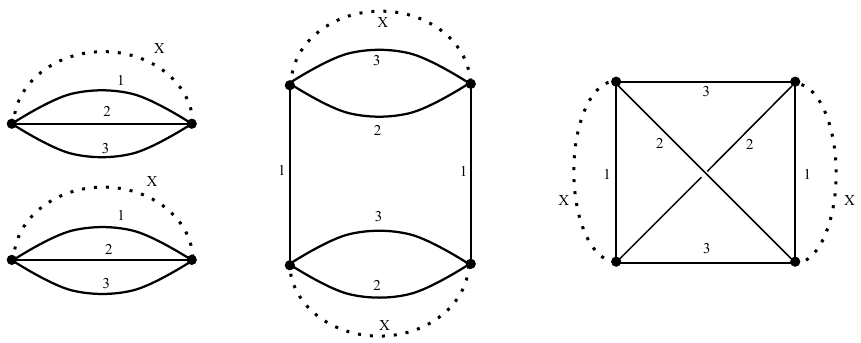
Figure 1 . Graphical representation of the interaction vertices (2.7) (left), (2.8) (center), and (2.13) (right). Each vertex represents a tensor/spinor (cid:12)eld, a solid line with label (color) i joining two vertices represents the contraction of the i -th tensorial indices of the two (cid:12)elds at its end-vertices, and a dotted line with label X represents the contraction of the spinorial indices of the (cid:12)elds at its end-vertices, with the insertion of a matrix (cid:0) X . The discrete chiral symmetry (2.4) forbids a mass term in the action, and thus (2.6) is the only bilinear invariant under all our symmetries. In GN a mass is dynamically generated at the non-perturbative level, and we will address in some detail the question of dynamical symmetry breaking for our models in the upcoming